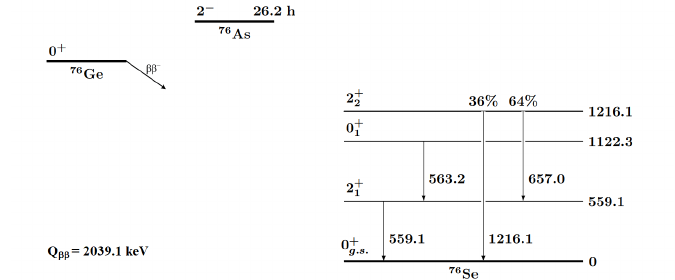
Figure 12. Scheme of 2 β − decay of 76 Ge to the ground state and to the first excited levels of 76 Se. The energies of the levels and the relative main branching ratios are taken from Reference